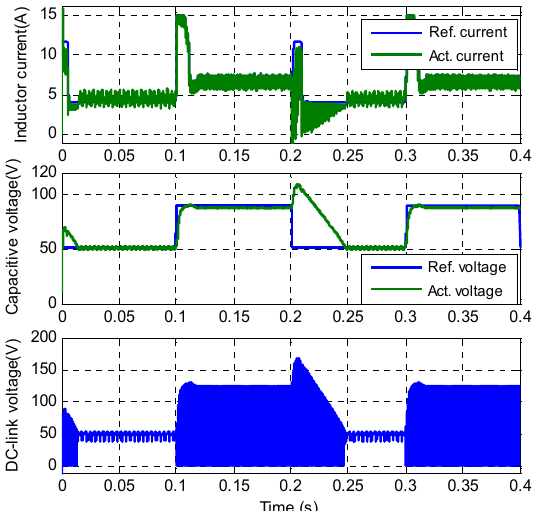
Figure 7. The dynamic performance of the qZSI side with modulated FCS-MPC. From top to bottom: inductor current, capacitor voltage, and DC-link voltage.